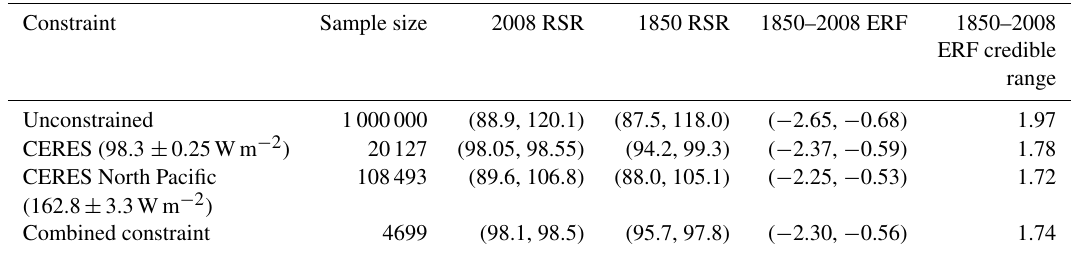
Figure 12. (a) Observationally constrained present-day ToA RSR and the values of 1978 and 1850 ToA RSR and (b) 1978–2008 and (c) 1850–2008 aerosol ERF values from matching model variants. For each output variable the black lines show 95% credible intervals of the unconstrained 1-million-member sample of model variants. The black box contains all model variants within ± 0.25Wm − 2 of the CERES-observed global annual mean present-day ToA RSR value. Purple boxes represent the 95% credible intervals of values obtained using model variants (parameter combinations) in the observationally constrained sample. Output from the simulation with all parameters set to their median values is shown as dots. The median 1850–2008 aerosol ERF from the observationally constrained sample is displayed as a diamond. Table 4. Present-day ToA RSR constraints and the resulting 95% credible intervals of 1850 RSR and 1850–2008 aerosol ERF (Wm − 2 ) for the unconstrained and constrained